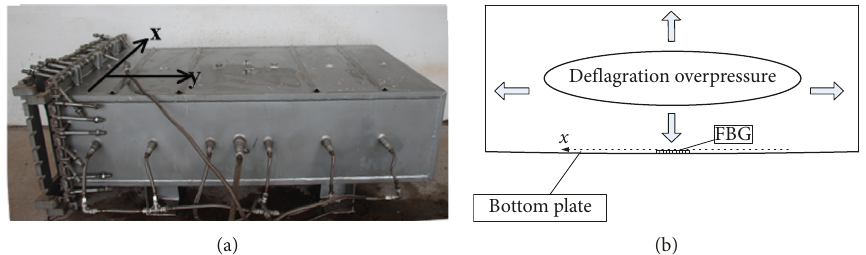
Figure 10: Schematic diagram of the strain of the FBG measurement in the x direction. (a) Test device. (b) Cross-sectional view in the x direction.